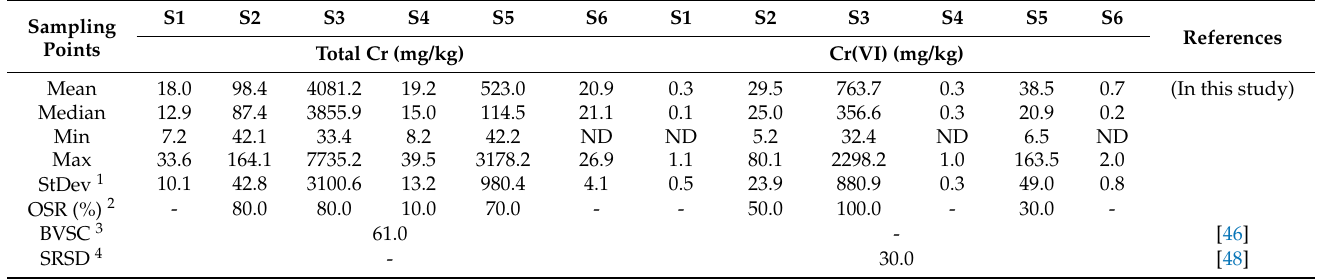
Table 1. The basic statistical parameters of the soil chromium contents in the electroplating